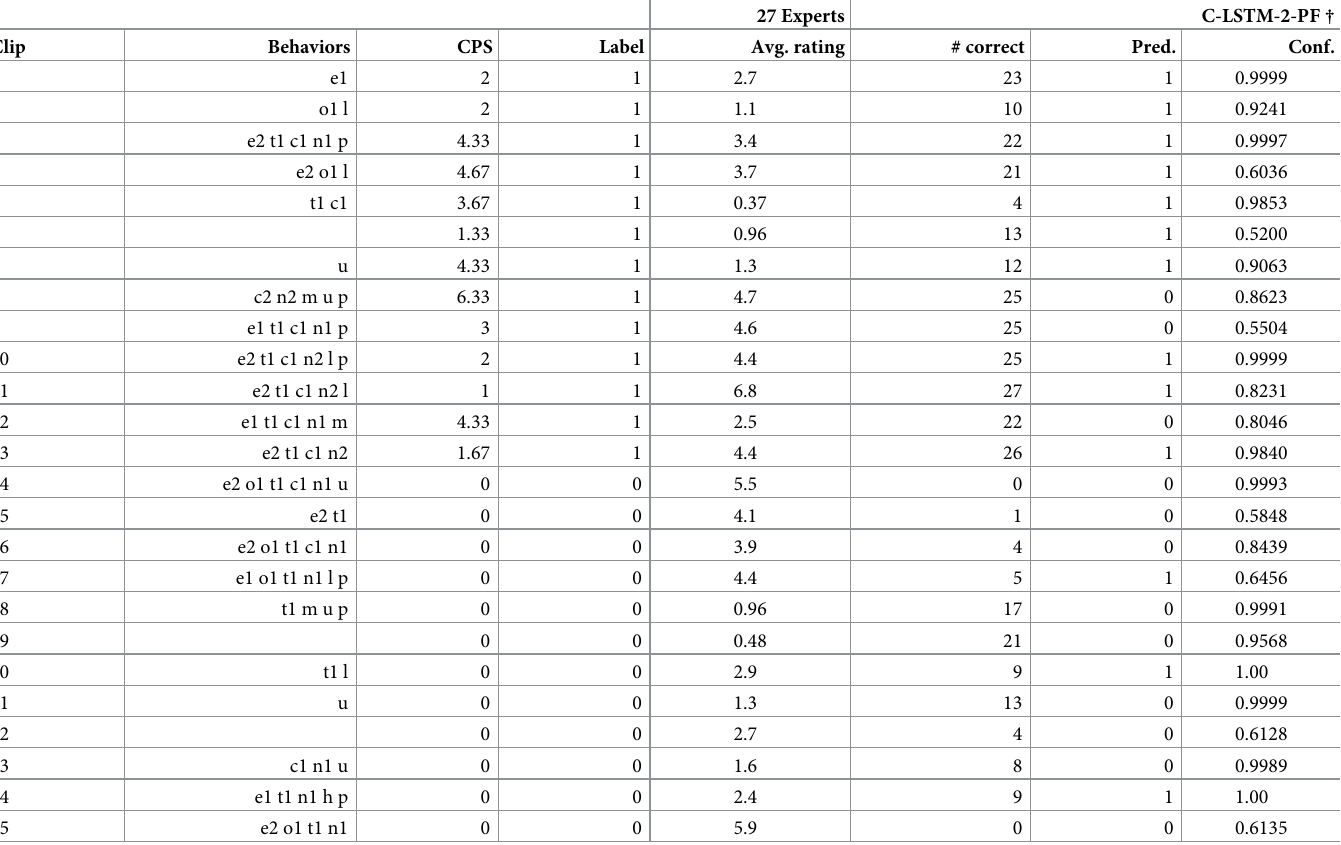
Table 2. Overview of the predictions on 25 EOP(j) clips made by the human veterinarian experts and by one C-LSTM-2 instance, trained only on PF. The labels for the C-LSTM-2 were thresholded above 0 (same threshold as for the experts). The behavior symbols in the Behavior column are explained in Table